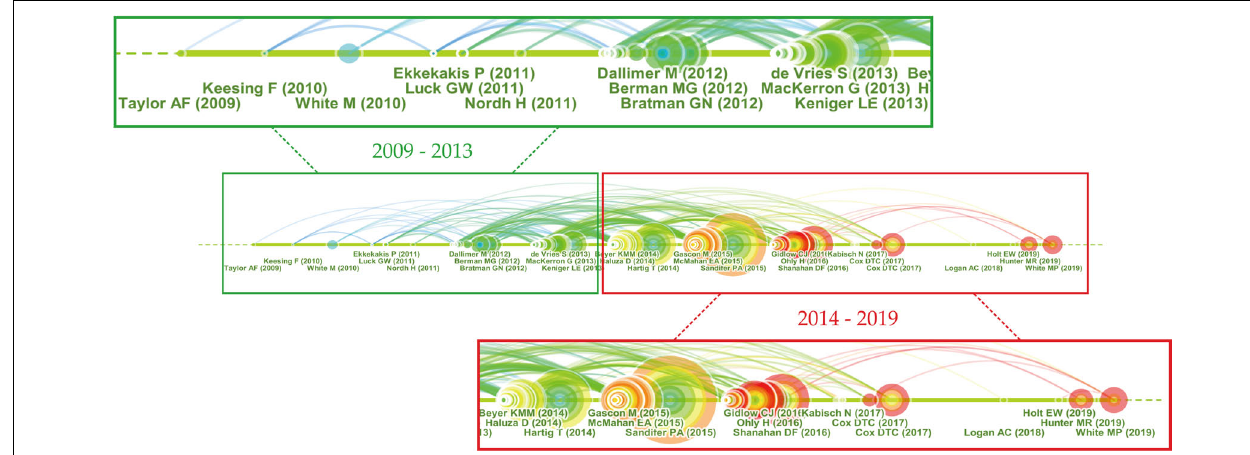
FIGURE 8 | High-impact publications in Cluster #0.